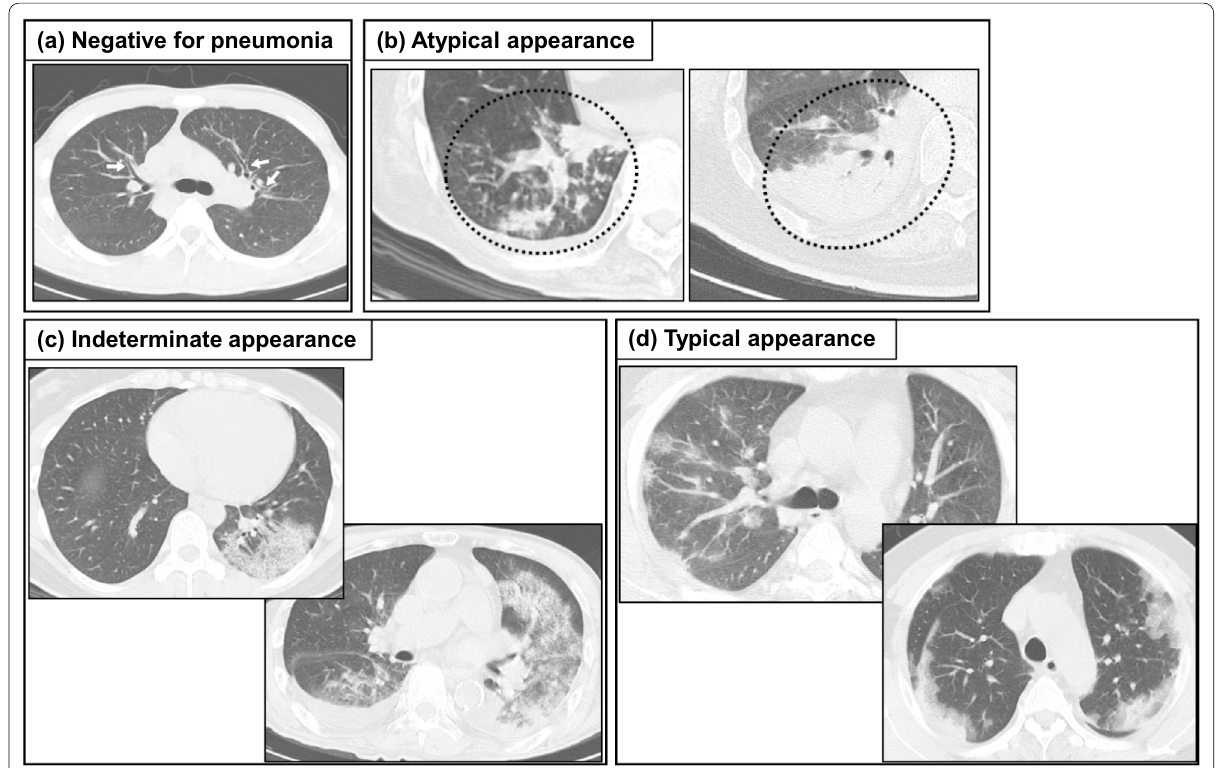
Fig. 1 Example of chest CT patterns of RSNA classification. Axial CT images are categorized as ( a ) “Negative for pneumonia” meaning no features of pneumonia, ( b ) “Atypical appearance”, meaning typical for other infection but not COVID-19, e.g., bronchial pneumonia, lobar pneumonia, tuberculosis, or fungal infection, ( c ) “Indeterminate appearance”, meaning the presence of feature suspicious for COVID-19 but with overlaps with other diseases, drug-induced pneumonia, collagen disease-related lung diseases, or alveolar pulmonary edema, and ( d ) “Typical appearance”, meaning the typical pattern of COVID-19 pneumonia